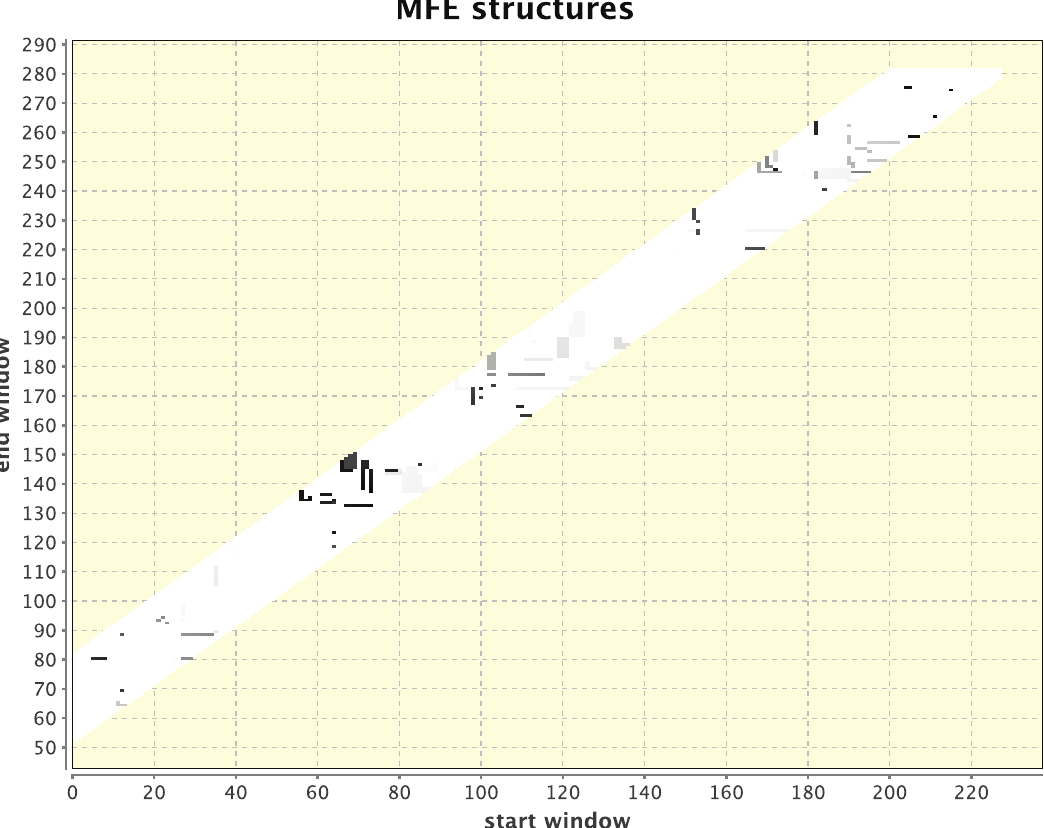
Figure 1. Simulated heat-shock response for homosapiens 70 kDa HSPA4. Parameter values are: windows: 55–80, temperatures: 37 u C and 40 u C. Sequence size is 281 nt. In inspecting the graphical plot, there is no special clustering of dots to indicate a signal for a potential RNA thermometer. The structural changes are sporadically distributed over the entire RNA sequence.